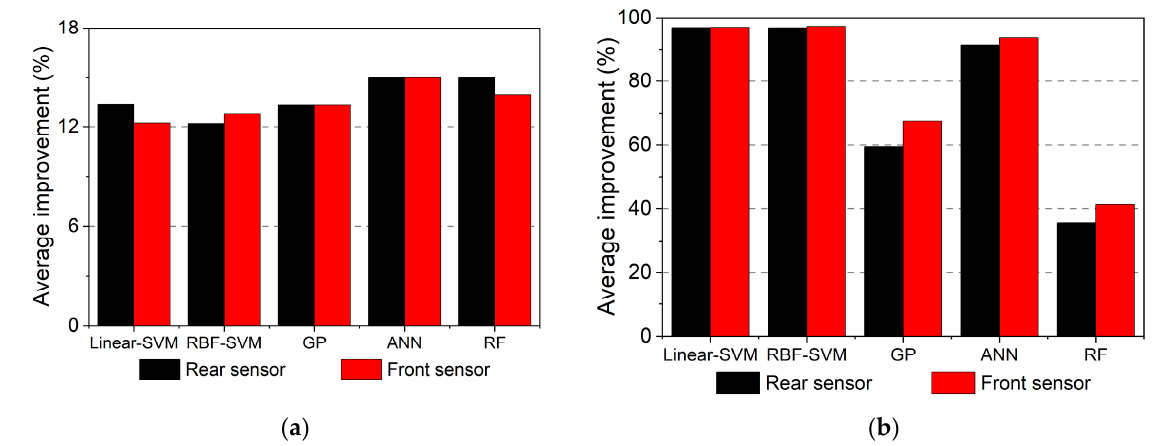
Figure 19. Comparison results for rear and front axles. ( a ) Accuracy, ( b ) E ffi ciency.